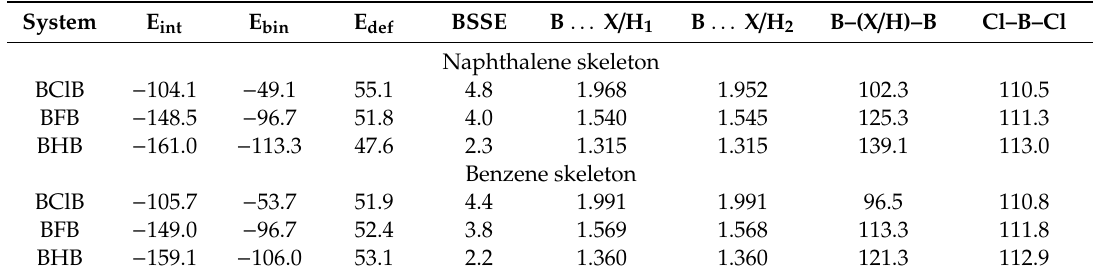
Table 1. The energetic (kcal / mol) and geometric (Å, degrees) parameters of the systems analyzed here, being the result of MP2 / aug-cc-pVTZ calculations; the interaction and binding energies corrected for BSSE are presented, E int and E bin , along with the deformation energy, E def , and the basis set superposition error, BSSE. The B ... X / H 1 / 2 distances in the B–(H / X)–B system are presented (subscripts 1 and 2 correspond to two distances within one system considered, X marks the halogen atom), and the B–(H / X)–B angle is included along with the mean Cl–B–Cl angle. Of the angles taken to calculate the latter mean value, those which contained a Cl − anion between boron centers (in two complexes) were not included. The mean Cl–B–Cl angles for neutral 1,8-bis(dichloroboryl)naphthalene and 1,2-bis(dichloroboryl)benzene were equal to 116.3 ◦ and 117.5 ◦ ,